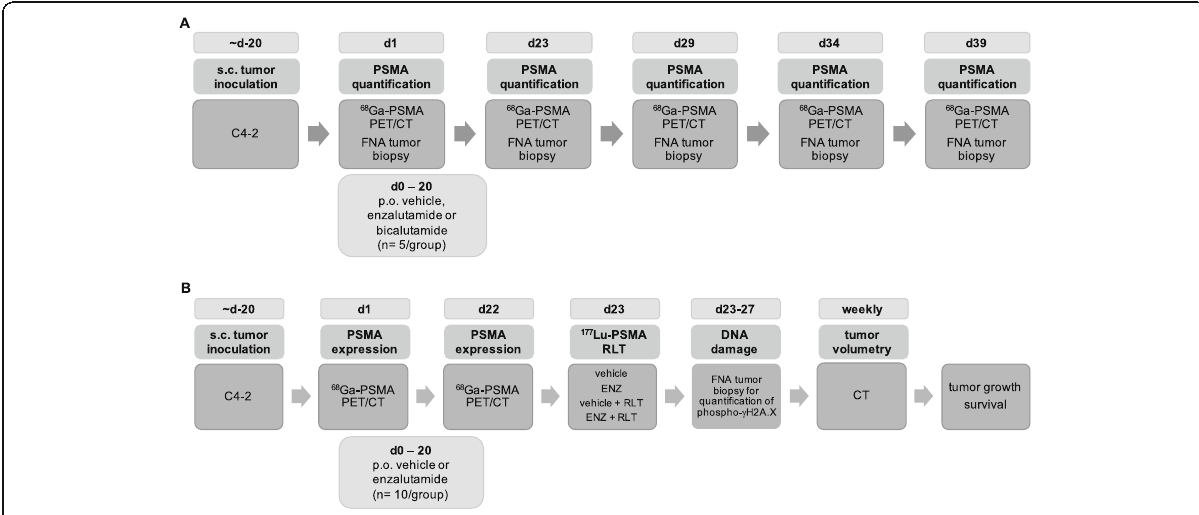
Fig. 1 Experimental design. a Investigation of ARB (ENZ vs. bicalutamide (BIC) vs. vehicle)-mediated PSMA upregulation in C4-2 xenografts. b Testing efficacy of pre-treatment with ENZ before PSMA-RLT in C4-2 tumors. DNA damage was assessed 4 h, 2 and 4 days post RLT by flow cytometric quantification of phospho- γ H2A.X in FNA tumor